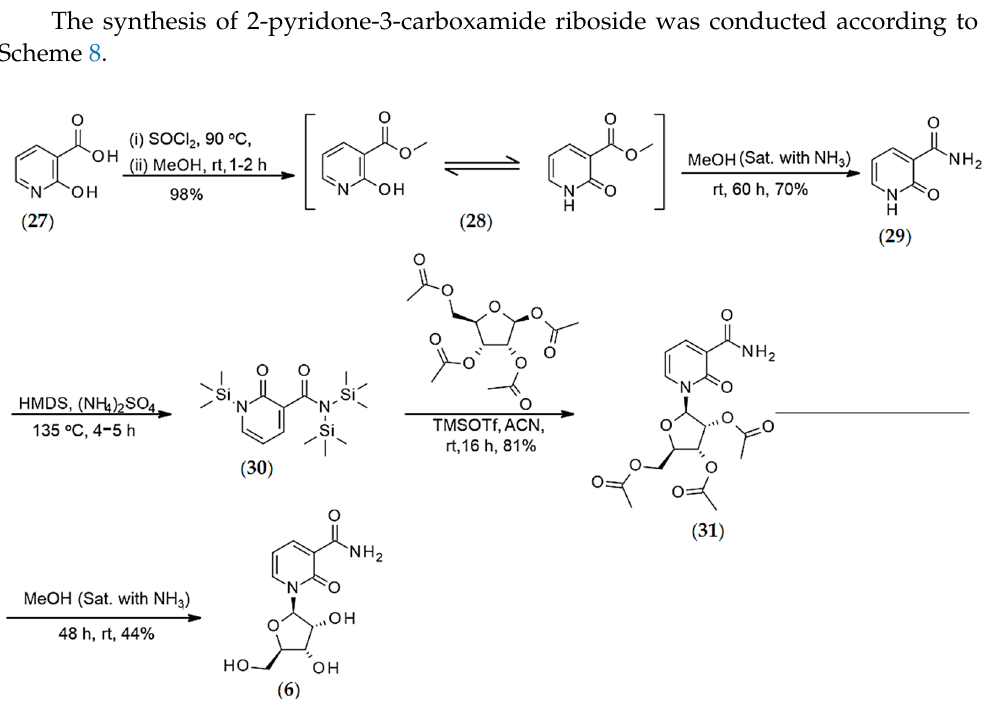
Scheme 8. Synthesis of the 2-pyridone-3-carboxamide